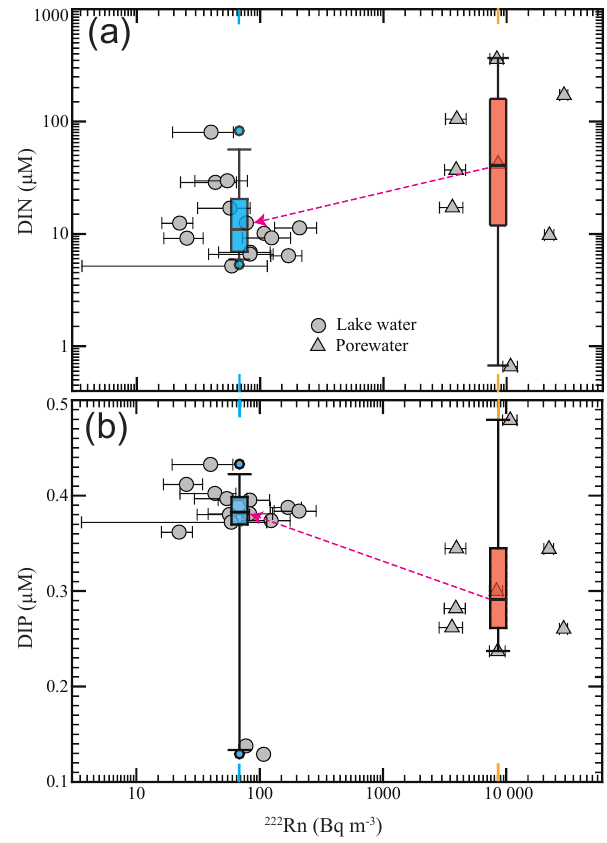
Figure 5. Cross plots of 222 Rn versus DIN (a) and DIP (b) .